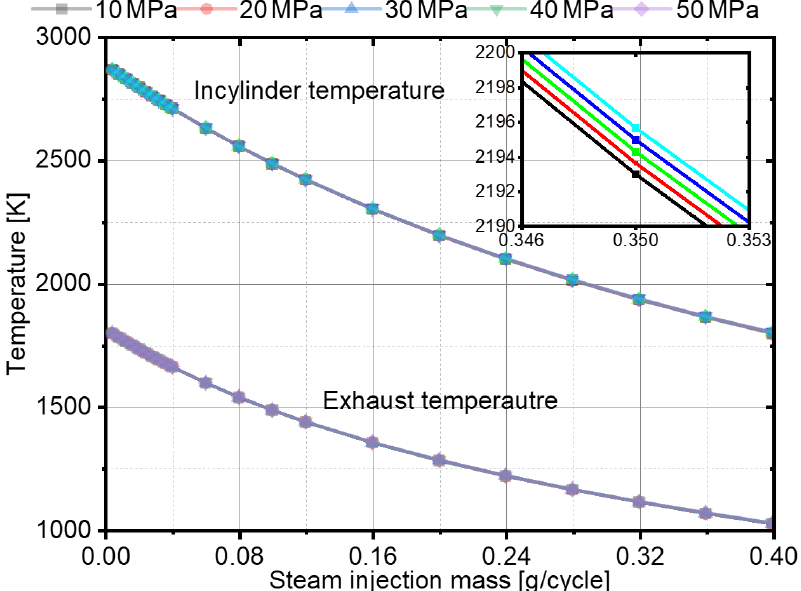
Figure 6. Relationships between in-cylinder/exhaust temperatures and steam injection mass at various injection pressures (T steam = 450 K; P inkate = 0.1 MPa; CR = 10).